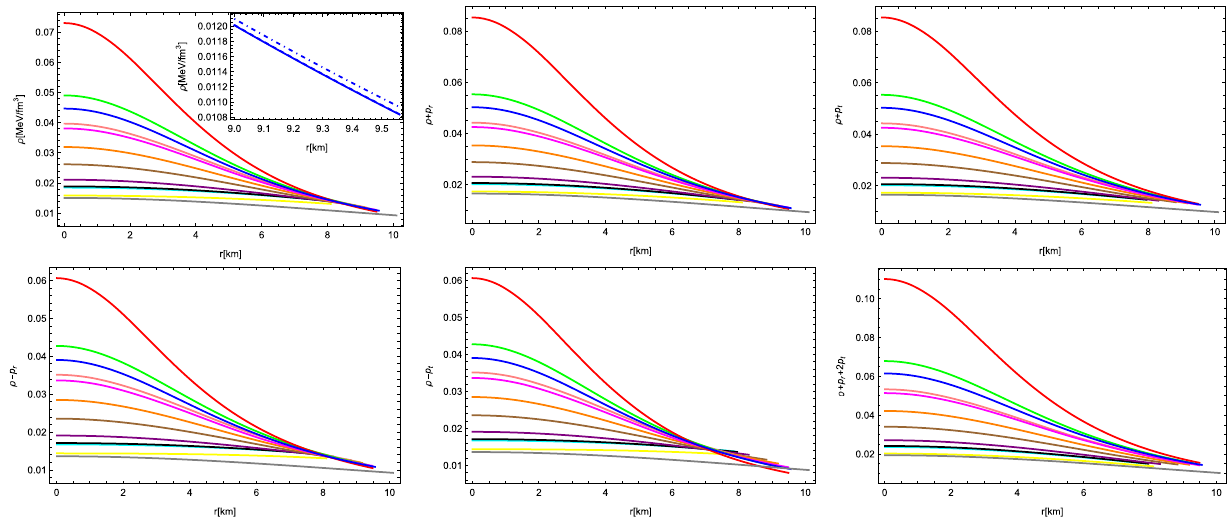
Fig. 5 Profiles of the energy conditions of S 1 ( (cid:2) ), S 2 ( (cid:2) ), S 3 ( (cid:2) ), S 4 ( (cid:2) ), S 5 ( (cid:2) ), S 6 ( (cid:2) ), S 7 ( (cid:2) ), S 8 ( (cid:2) ), S 9 ( (cid:2) ), S 10 ( (cid:2) ), S 11 ( (cid:2) ), S 12 ( (cid:2)